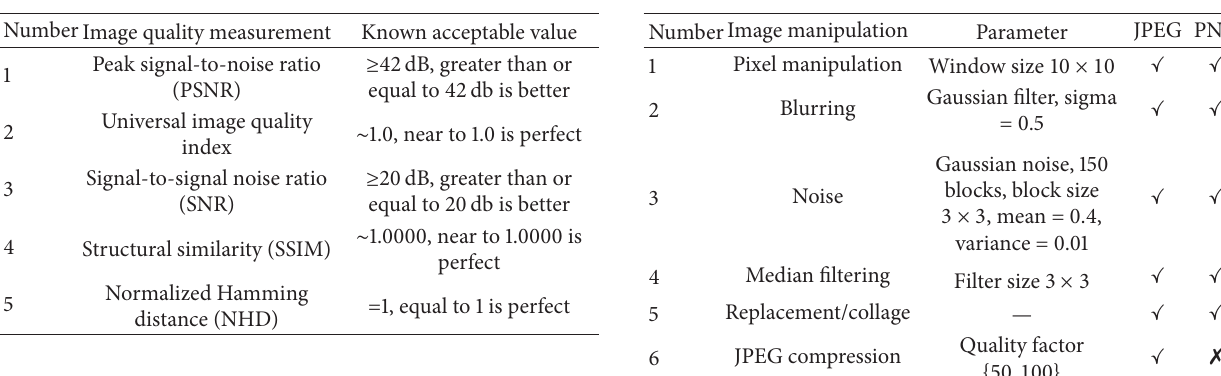
Table 3: Known acceptable value in image quality measurement. Table 4: Six image manipulations applied on